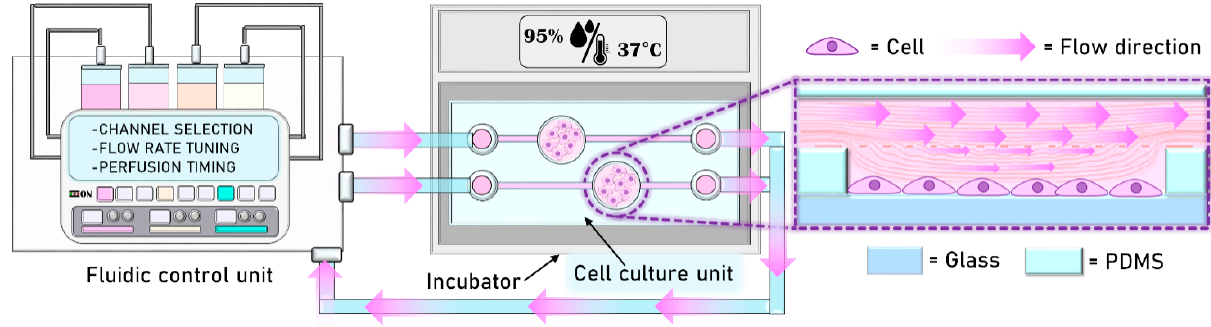
Figure 1. Schematic representation of the microfluidic control platform, including the control module and disposable PDMS unit.